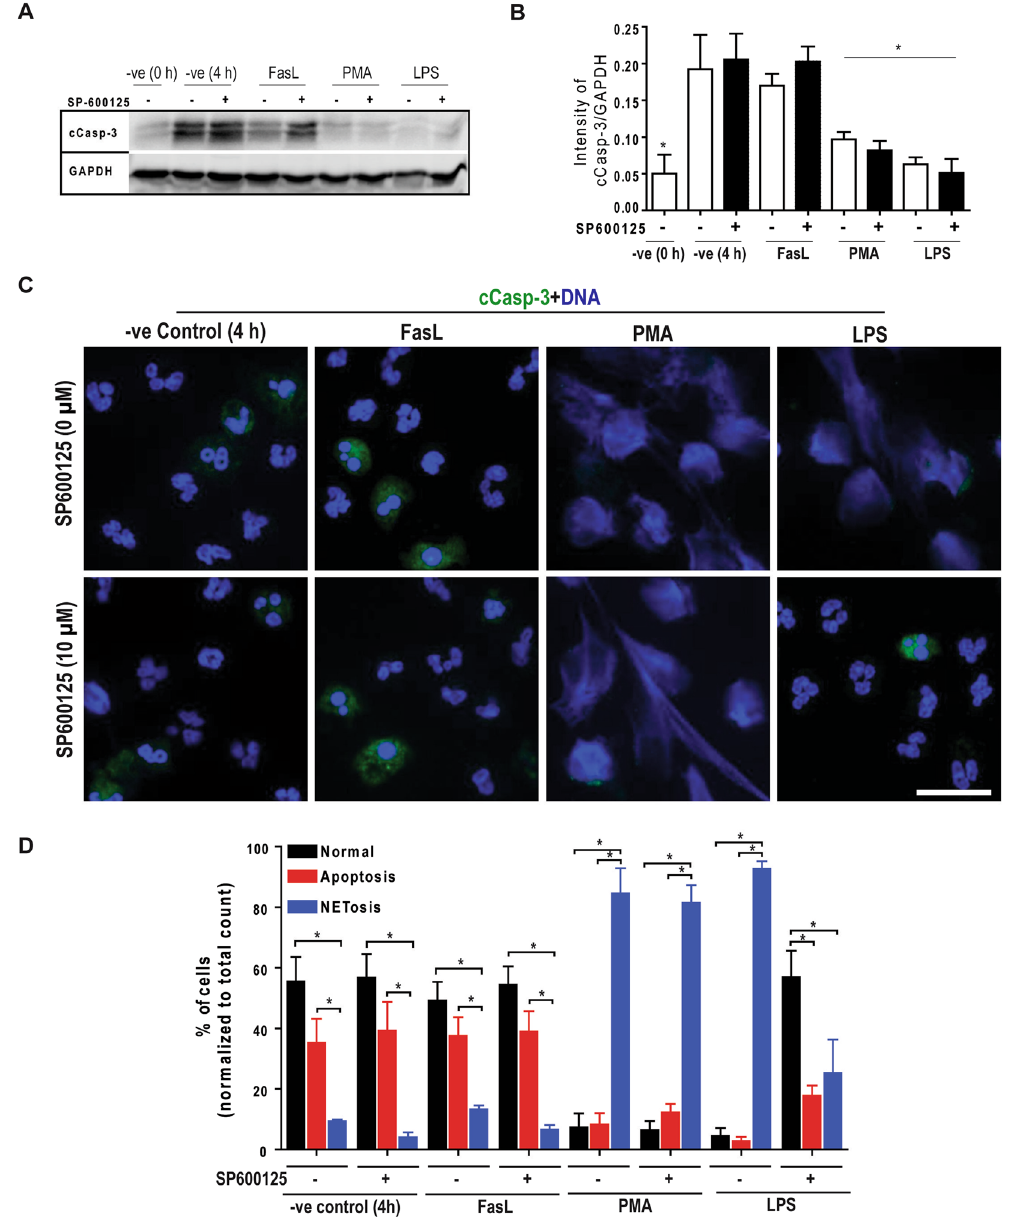
Figure 7. Inhibition of JNK in LPS-treated neutrophils does not lead to apoptosis, and maintains cell survival. ( A–B ) Immunoblot analyses of the cleave caspase-3 (cCasp-3) show that neutrophils treated with media control for 4 hours in the presence or absence of SP600125 undergo apoptosis to the extent similar to that of Fas-L treatment. Neutrophils activated by 25 nM PMA and 25 μ g/ml LPS mostly show NETosis. Treating neutrophils with LPS and SP600125 shows no cCasp-3; NETosis in these cells are very low ( * p < 0.05; One-way ANOVA with Tukey’s multiple comparison post test). ( C ) Confocal microscopy of the neutrophils stained with DAPI (blue) and cCasp-3 (green) after 4 hours. Images show some of the non-activated control neutrophils stain for cCasp-3, in the presence or absence of SP600125. Treating neutrophils with LPS, PMA and PMA with SP600125 exclusively show signs of NETosis; only traces of cCasp-3 is visible in a few of these cells. Treating neutrophils with LPS and SP600125 show no cCasp-3 or NETs (n = 3; scale bar 20 μ m). See Supplementary Fig. S7 for the low magnification images. ( D ) The percentages of normal, apoptotic and NETotic cells were calculated based on cCasp3 staining and nuclear morphology. The quantitative analysis confirms the qualitative analysis (n = 3; * p < 0.05; One-way ANOVA with Tukey’s multiple comparison post test). Error bars in all the panels represent SEM. Collectively, inhibition of JNK activation during LPS-mediated activation of neutrophils result is cell